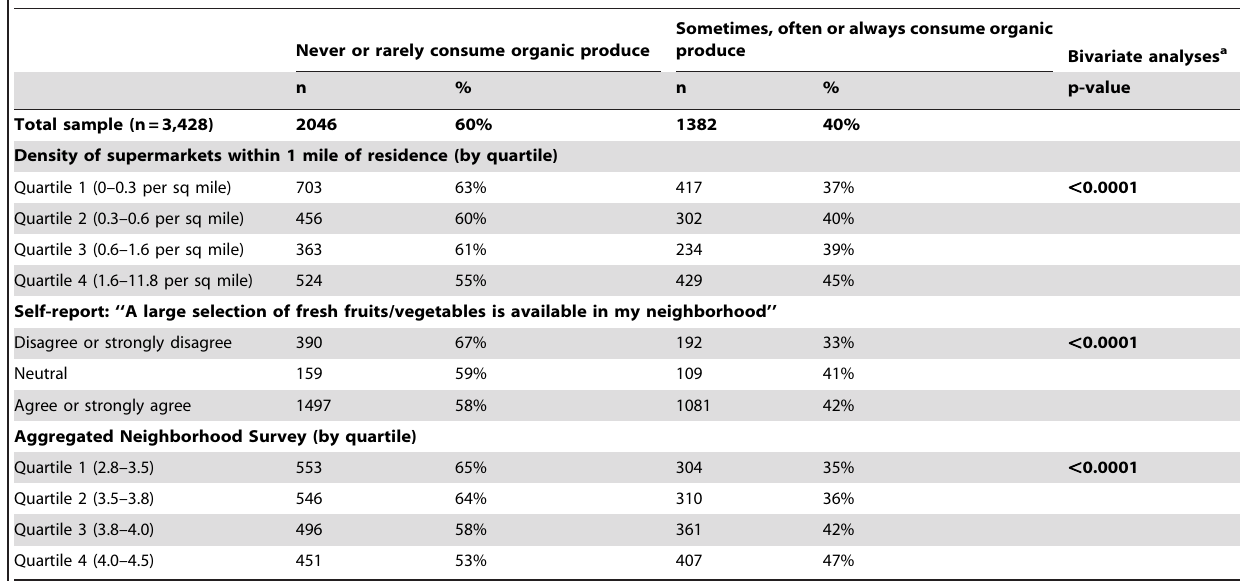
Table 3. Frequency of organic food consumption in relationship to measures of the local food environment.